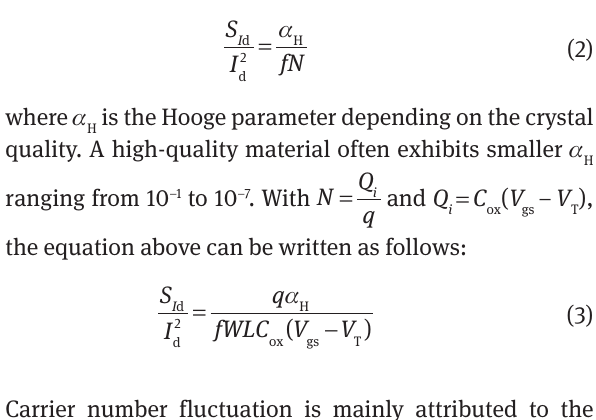
/Si and (B) SiO /Si at different temperatures and gate 2 2